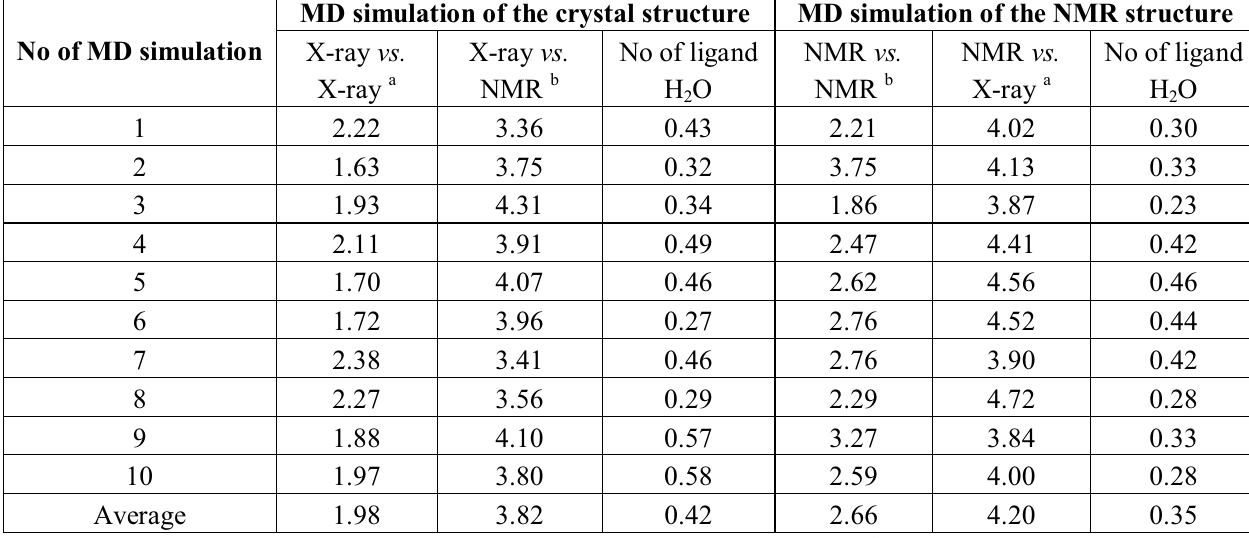
Table 1. RMSD of main-chain atoms in Å unit after 10-ns MD simulations.